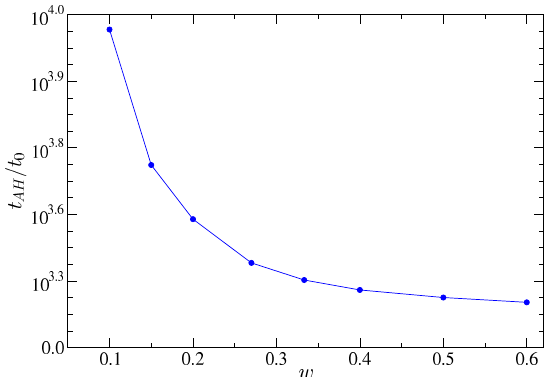
Figure 11. Spectral convergence for different profiles. Red points correspond to the profile of Equation (83) with q = 1, blue points to q = 5, and green points to q = 10 ( λ = 0 in all cases). The black solid line is the exponential fit ∼ e − α N cheb . ( Left-panel ): Case with a single grid N cheb and α ≈ 0.23,0.032, 0.022 respectively for the previous cases. ( Right-panel ): Case with two grids N 1 and N 2 = 50, with the second grid starting at r = 2 r m , and α ≈ 0.59,0.12,0.06, with the same profiles of the left panel. The simulation corresponds to δ m = 0.5 and t = t H for w = 1/3.